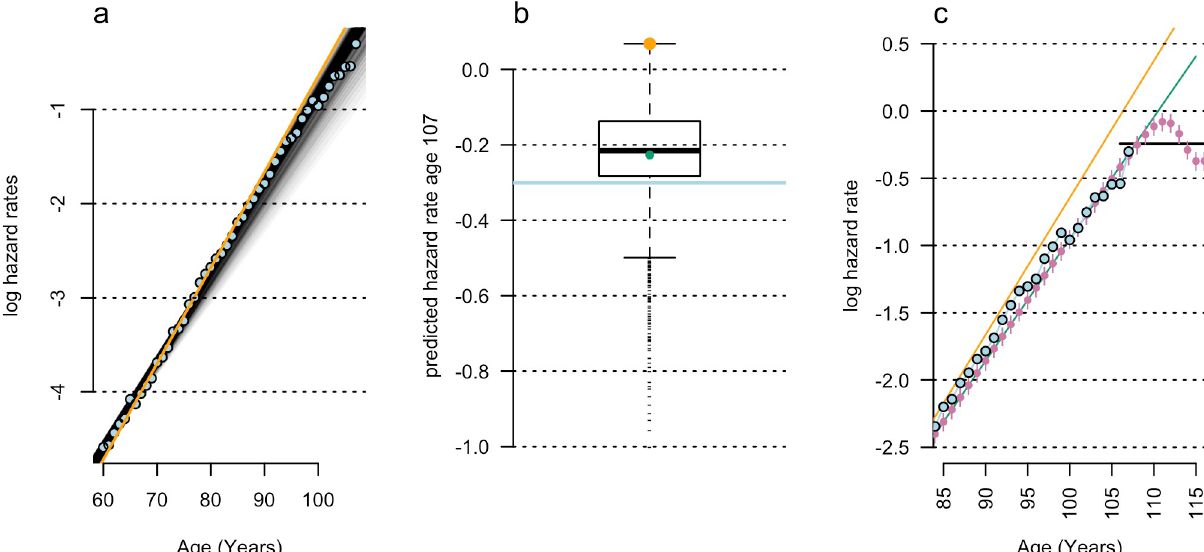
Fig 2. Effect of model selection on the size of apparent mortality plateaus. (a) Observed hazard rate data (blue) from Barbi and colleagues [1], fitted by log-linear hazard rate regressions for 861 diverse age ranges (grey lines). The Barbi and colleagues [1] age range (orange) produces the largest late-life mortality plateau and (b) produces the greatest overestimate of observed data (orange cross) at advanced ages (blue line, age 105 shown). Seeding random errors into other representative models—e.g., the 50- to 80-years-old regression (green point in (b), green line in (c))—produces (c) late-life mortality deceleration (pink points; p = 2 × 10 − 4 ) and constant hazard-rate regressions (black line) past age 105.